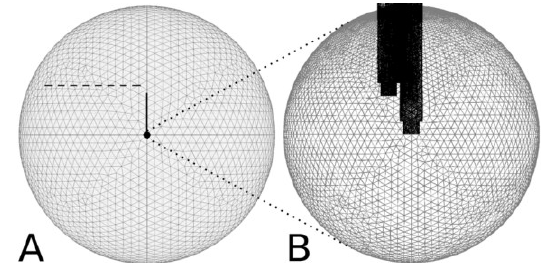
Figure 3: Schemes illustrating the geometries used in the finite- element simulations of the unipolar and bipolar electrodes. (A) Locations of the electrodes (vertical line) and the counter electrode of the unipolar electrode (dashed). (B) Locations of the electrode tips in the central, spherical domain with the finer mesh. The diameters of the outer and inner spherical domains were 80 and 2 mm,